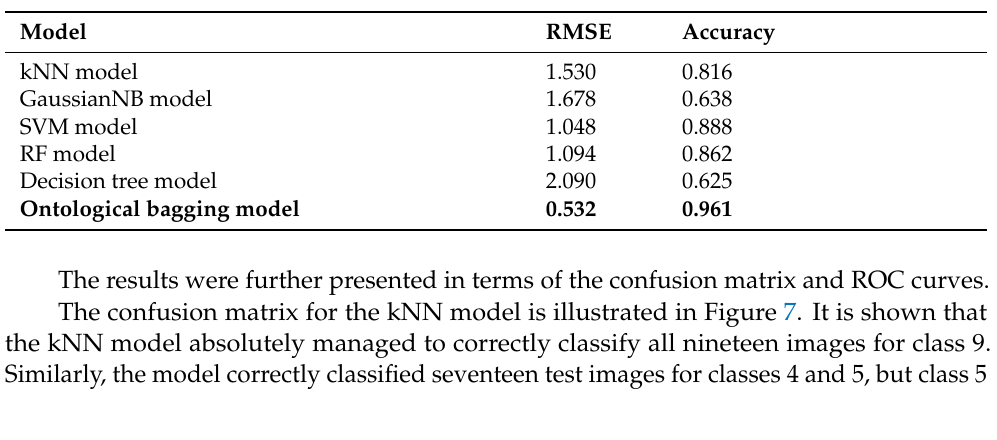
Table 5. Accuracy and RMSE scores of the proposed model against baseline models such as kNN, GaussianNB, SVM, RF, and decision